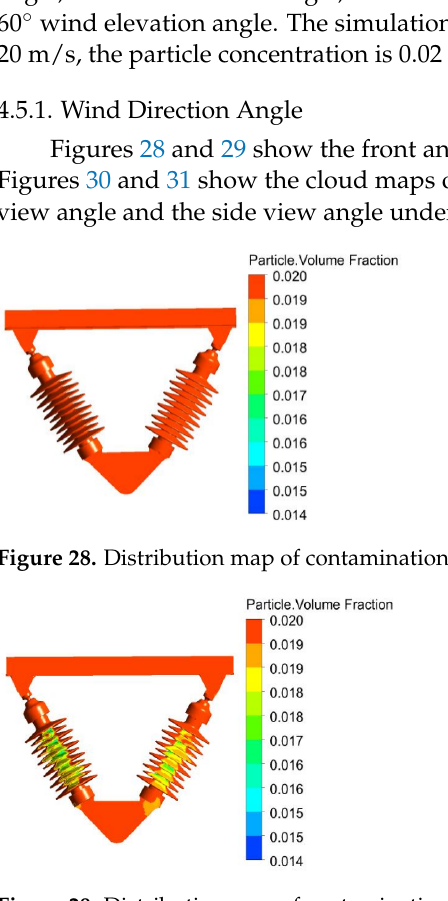
Figure 29. Distribution map of contamination on the back of the